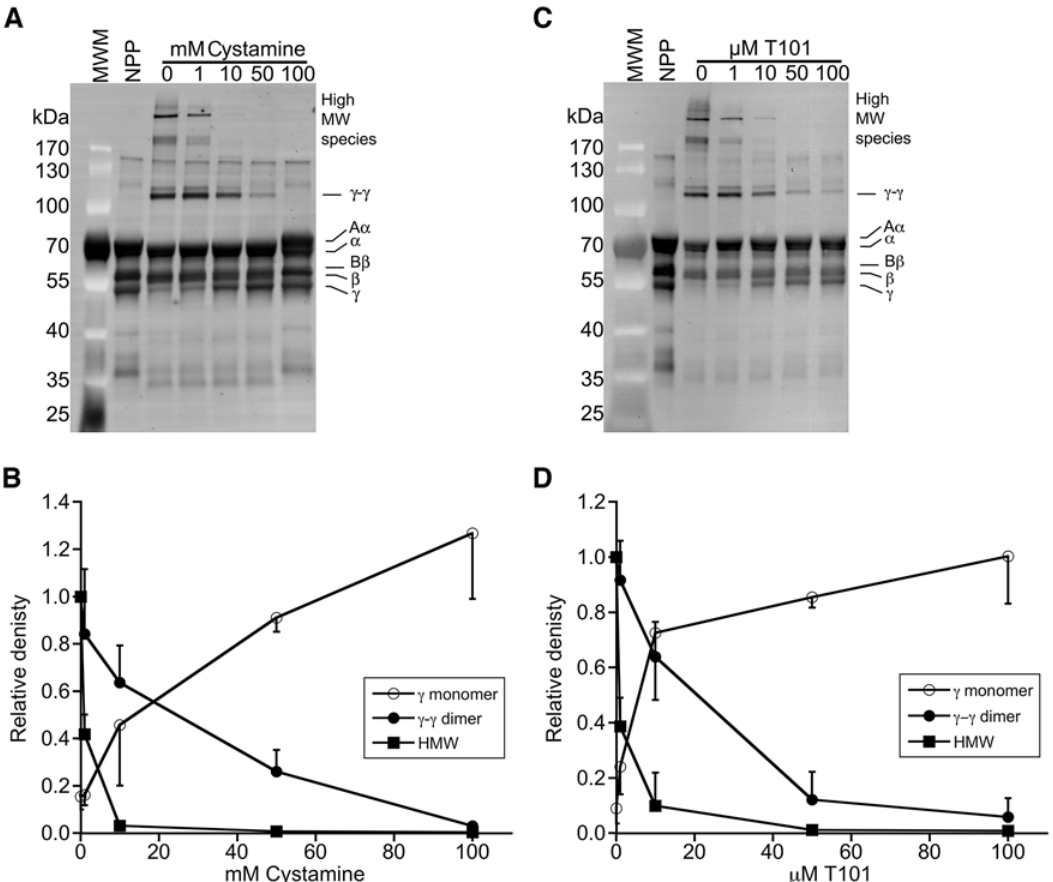
Fig 1. Cystamine inhibits fibrin crosslinking. Representative western blots and densitometry analysis showing the effects of cystamine (A, B) and T101 (C, D) on fibrin formation and crosslinking. Plasma was clotted by re-calcification and addition of lipidated tissue factor in the presence of cystamine or T101. Samples were reduced, boiled and separated by SDS-PAGE and identified by western blotting with anti-fibrinogen polyclonal antibody. MWM, molecular weight marker. NPP, un-clotted normal-pooled plasma. The upper high MW band (indicated by asterisk on the blot) was used for densitometry analysis of this